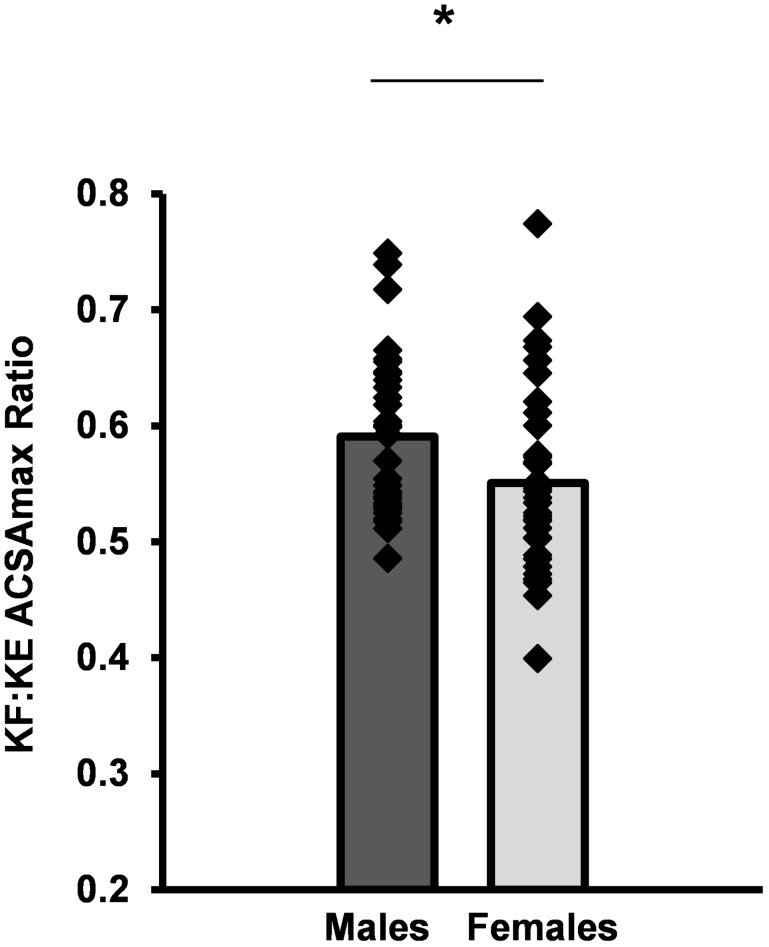
Knee flexors (KF) to knee extensor (KE) ACSAmax ratio for individual participants (diamonds) and mean for males (n = 32, dark grey bar) and females (n = 34 light grey bar).* P<0.05.